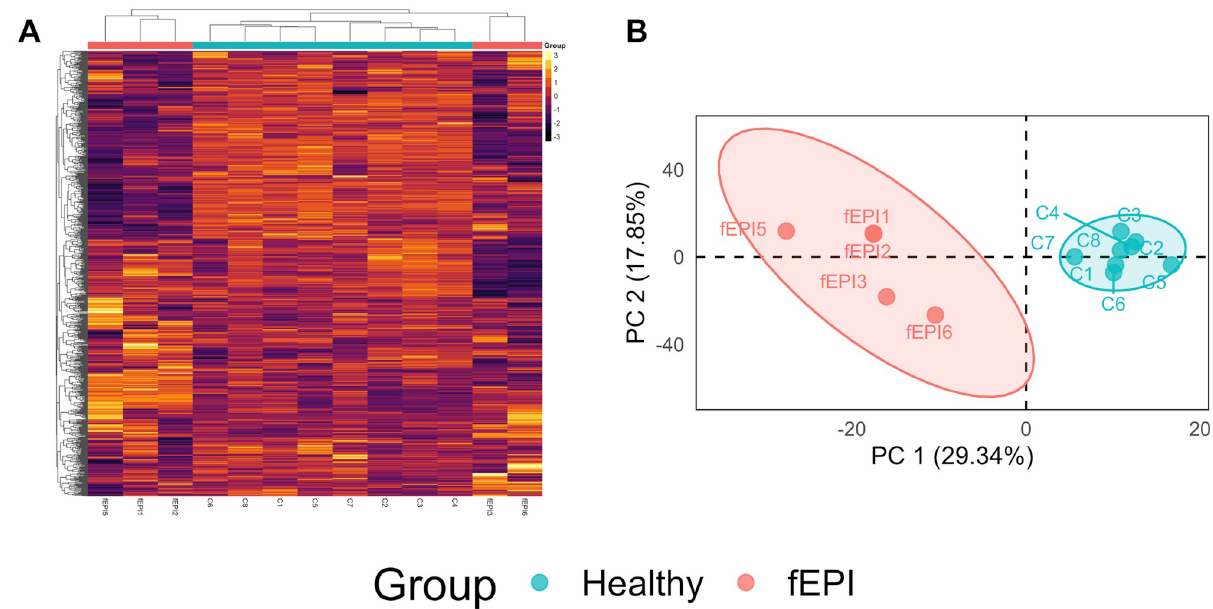
Fig 1. Unsupervised analysis of serum metabolite profiles. A. A statistical heatmap of metabolite abundance and clustering dendrogram of samples based on their Euclidian distances revealed separation of cats with EPI from healthy controls. The color of each cell is proportional to the z-scaled abundance of each metabolite. B. PCA separates samples from cats with EPI from healthy controls along the first principal component. The colored ellipse surrounding each cluster of samples represents the 95% confidence interval.